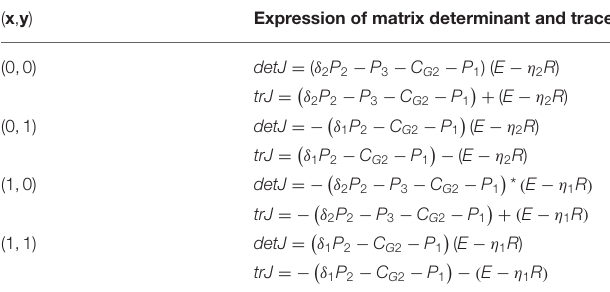
TABLE 2 | The expression of matrix determinant and trace corresponding to equilibrium points. ( x , y ) Expression of matrix determinant and trace